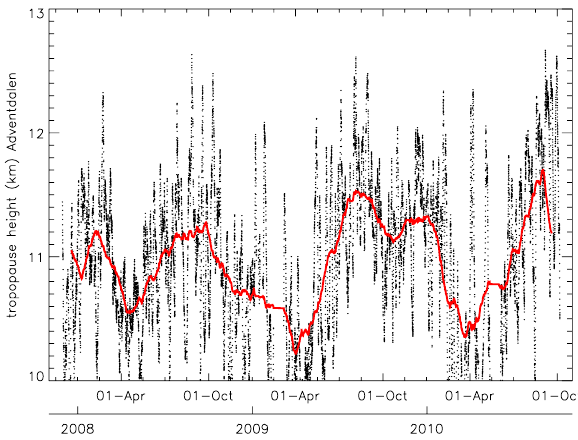
Fig. 1. Tropopause heights (radar tropopause) since November 2007, as determined by SOUSY. Daily medians of hourly values are indicated by black dots; thick solid line shows result of applying a 30-day